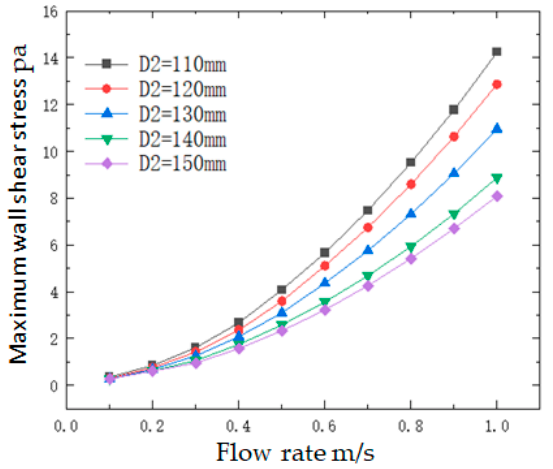
Figure 17. The influence of flow rate on the erosion of the tee.